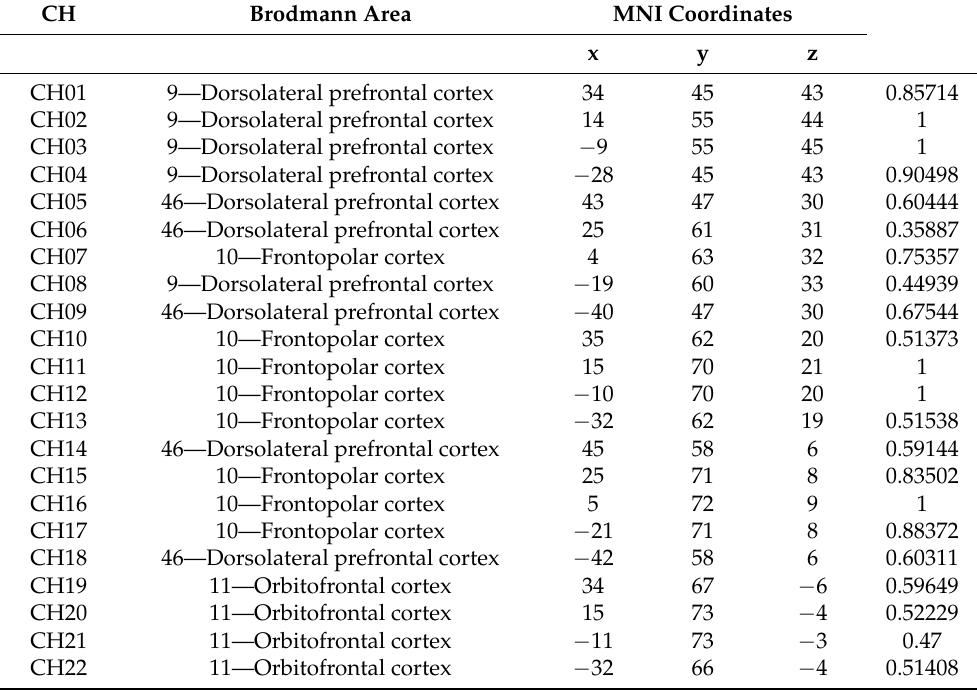
Table 3. Mean locations of 22 fNIRS